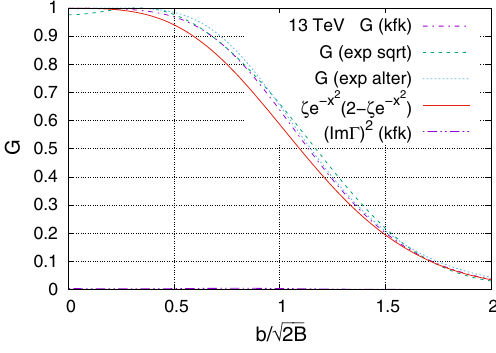
Fig. 1 The transverse impact-parameter profile ( G ) of inelastic colli- sions of protons at 7 TeV in different assumptions: kfk-model (dash- √ d σ/ dt calculated from experimental data dotted line), Im f ( s , t ) = √ d σ/ dt inside the diffraction cone and (dash line), Im f ( s , t ) = −√ d σ/ dt outside cone also calculated from experimental Im f ( s , t ) = data(dottedline),shape ζ exp ( − x 2 )( 2 − ζ exp ( − x 2 )) with ζ = 0 . 95058 (solidline).Alsoitisshownsquareofimaginarypartof Γ forkfk-model (dash-double dot line, very small)